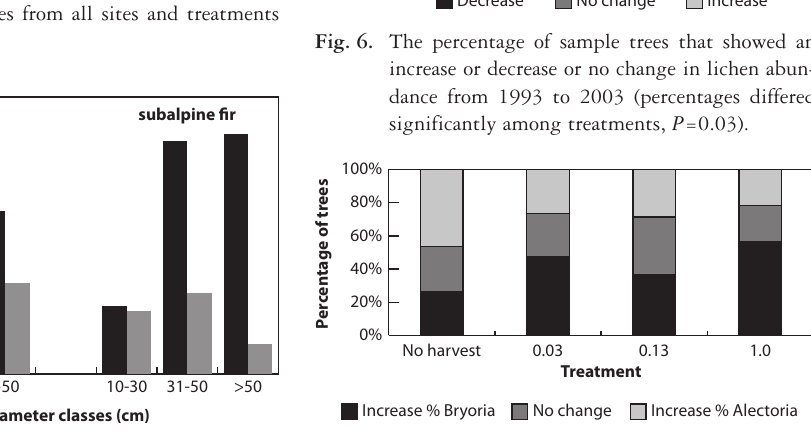
Fig.7. The percentage of sample trees that showed a change in composition (% Alectoria / Bryoria ) from 1993 to 2003 (differences among treatments were marginally significant, P